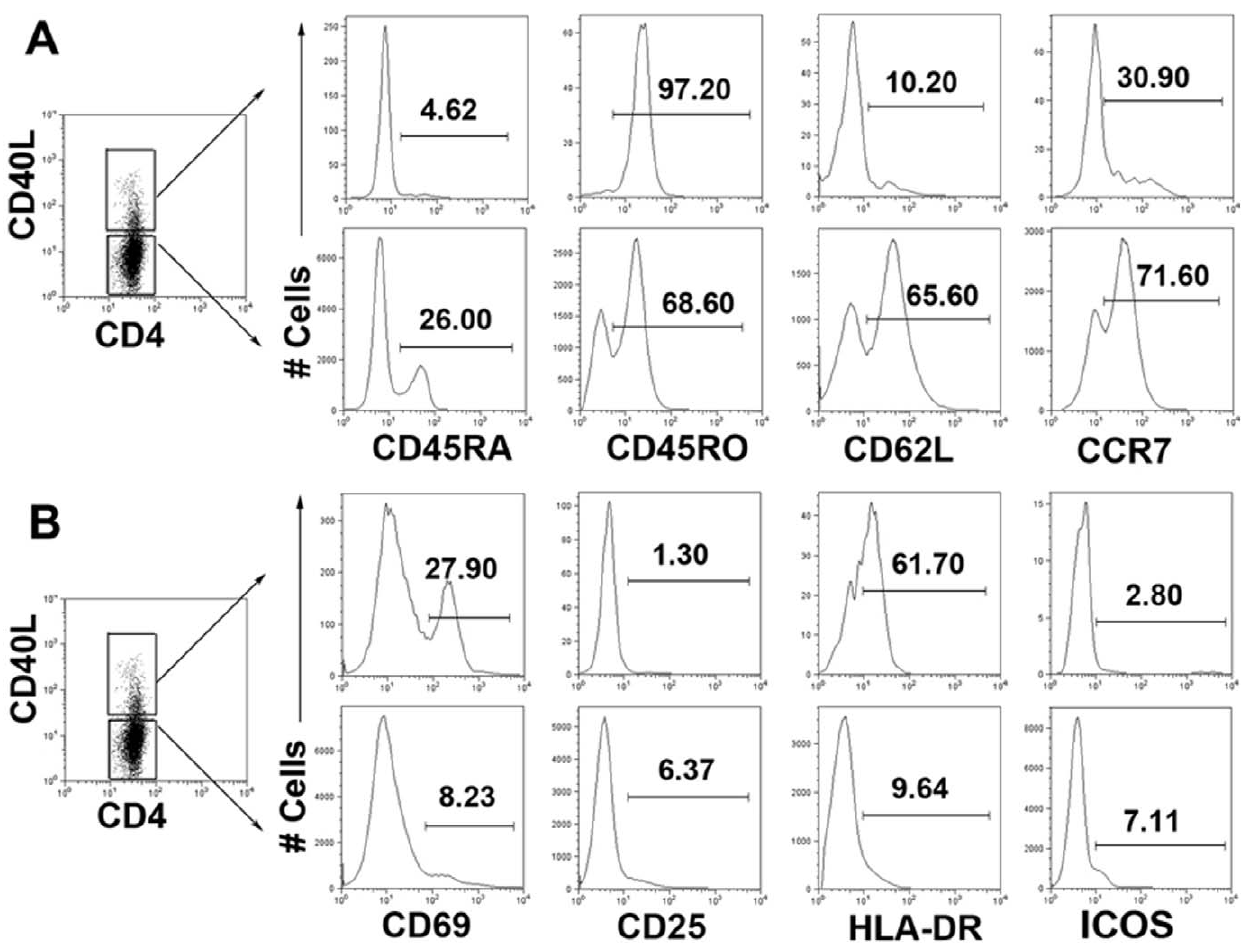
Figure 4. CD4 + CD40L + and CD4 + CD40L 2 T cells display different phenotypes. PFCs were stimulated with ESAT-6/CFP-10 peptides, anti- CD28 and anti-CD49d mAbs. CD4 + CD40L + and CD4 + CD40L 2 T cells were gated. (A) The expression of CD45RA, CD45RO, CD62L, CCR7 and (B) the expression of activation markers CD69, CD25, HLA-DR and ICOS by CD4 + CD40L + and CD4 + CD40L 2 T cells. One representative datapoint from five independent experiments is